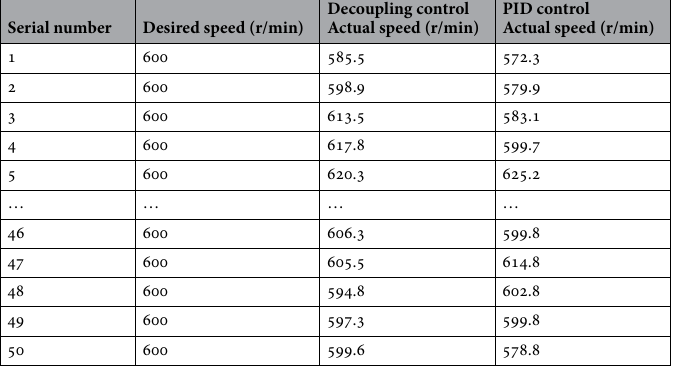
Table 3. Track performance